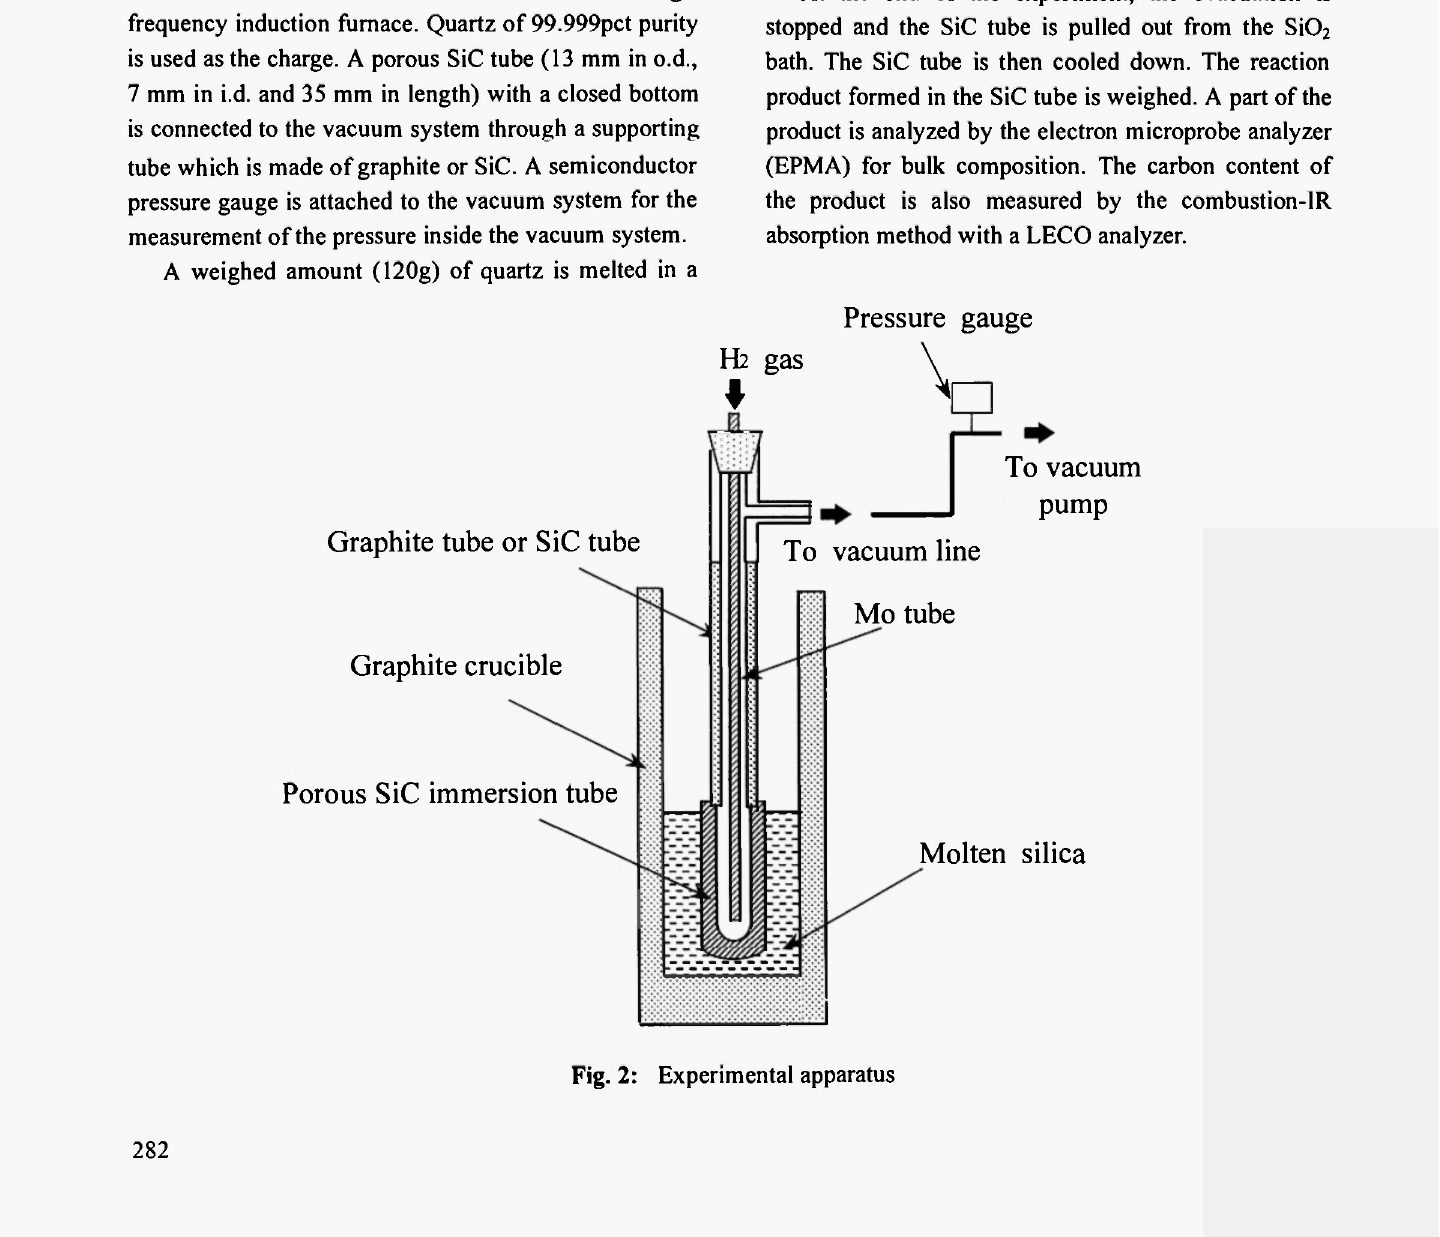
Fig. 2: Experimental